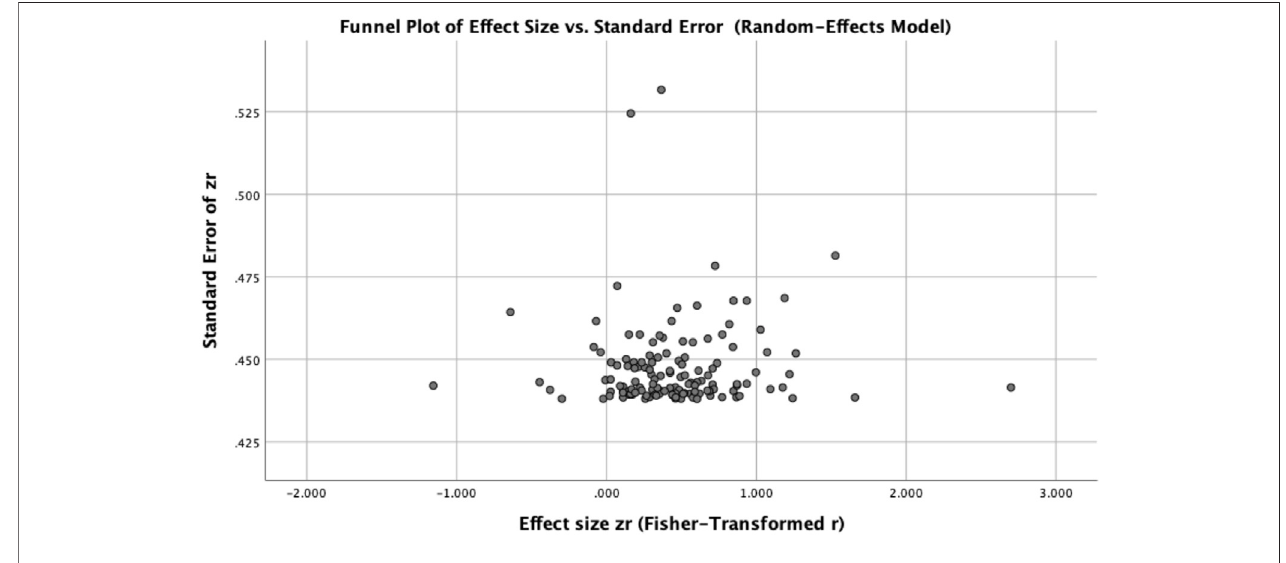
FIGURE 2 | Random effects funnel plot.